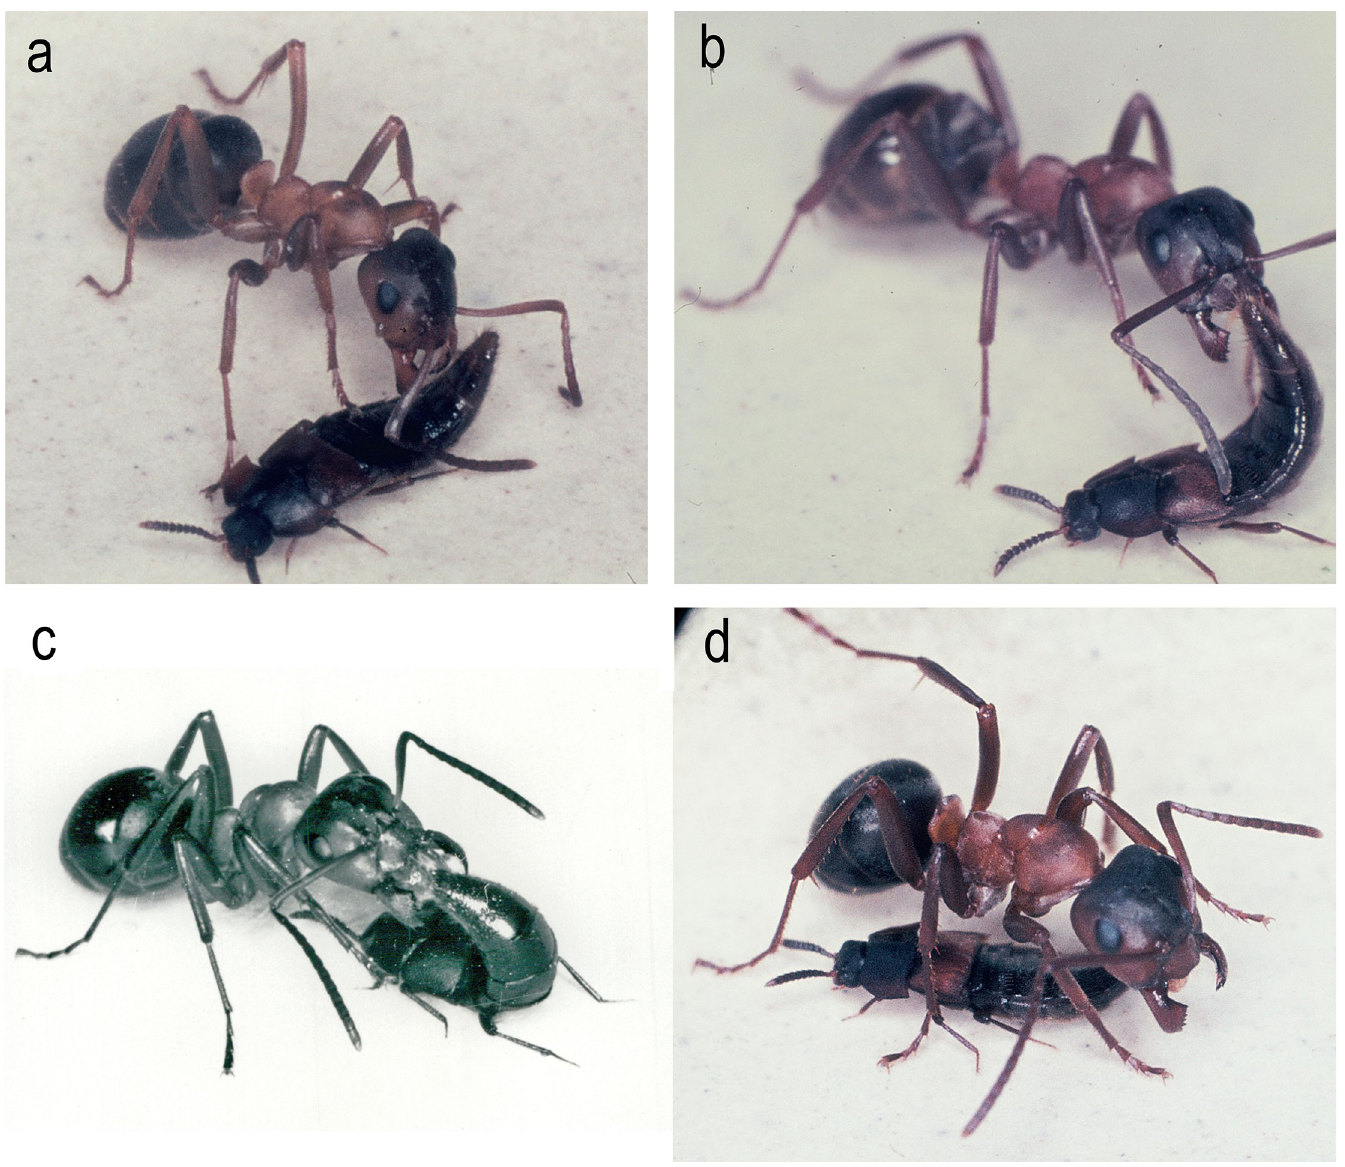
Fig 11. Appeasement interactions between Dinarda dentata and host ant Formica sanguinea . a) The host ant encounters a Dinarda beetle. The beetle reacts by raising its abdomen. b) The beetle’s abdomen is raised to reach the ant’s mouthparts. c) The ant extrudes its lower lip (labium) and licks the liquid at the abdominal tip of the beetle. d) This appeases the ant’s aggressive intentions and the beetle swiftly escapes.